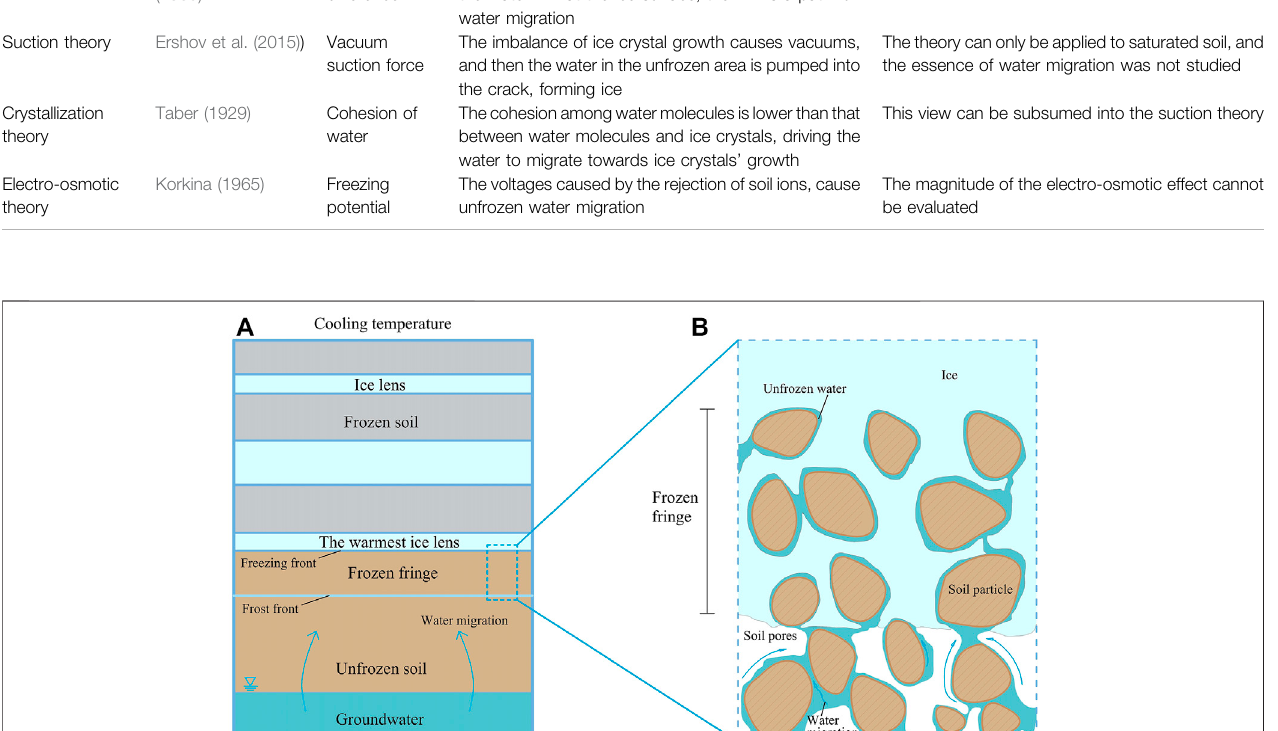
FIGURE 4 | A schematic diagram (not to scale) of frozen fringe: (A) shows the relative position of the frozen, frozen fringe, and unfrozen zones within freezing soil and, (B) is the magni fi ed views of the frozen fringe zone.